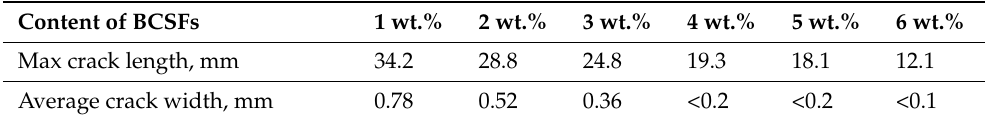
Table 5. Crack patterns of straight BCSF-reinforced UHPC specimens with 1–6 wt.% at 28 days after flexural strength